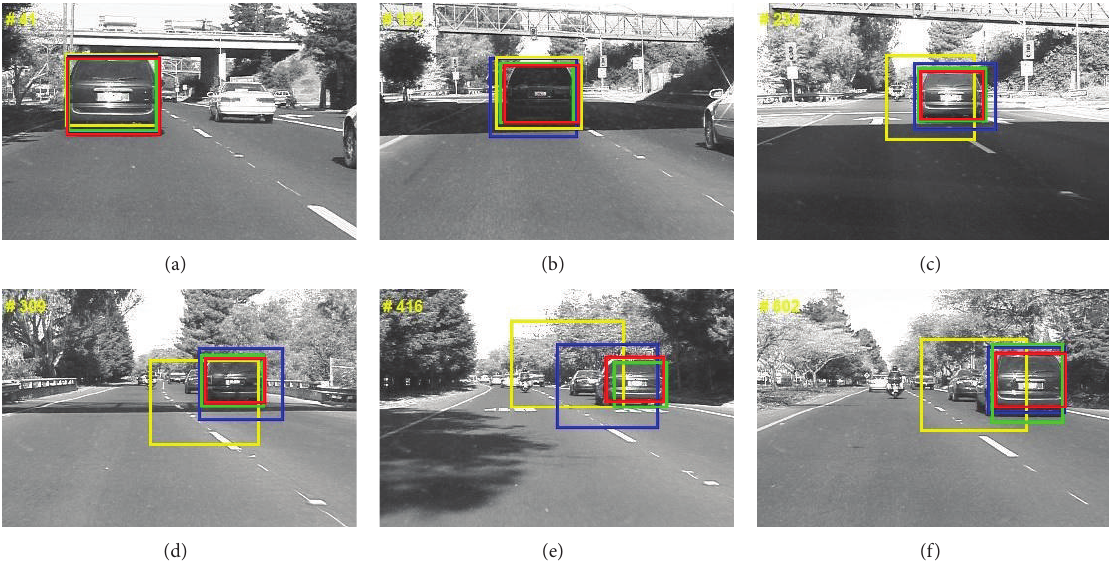
Figure 6: Tracking results of the Car4 sequence (MIL is yellow, IVT is blue, L1 is green, and our tracker is